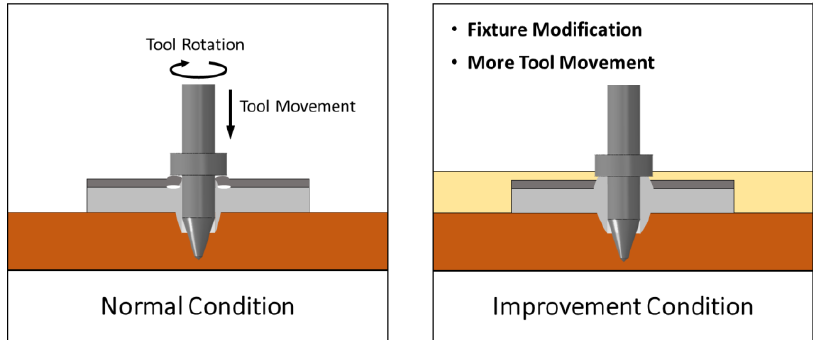
Figure 6. Schematic of friction drill joining process under normal and improvement conditions.